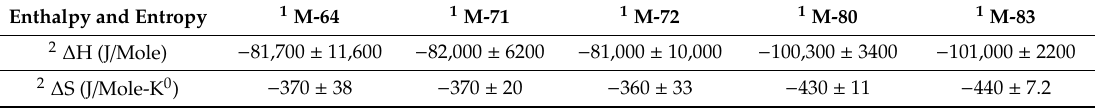
Figure 8. Ascending and descending pH profiles for polymer particles of M-72 and M-80 at 23 °C. Solid line = ascending pH profile. Dashed line = descending pH profile.